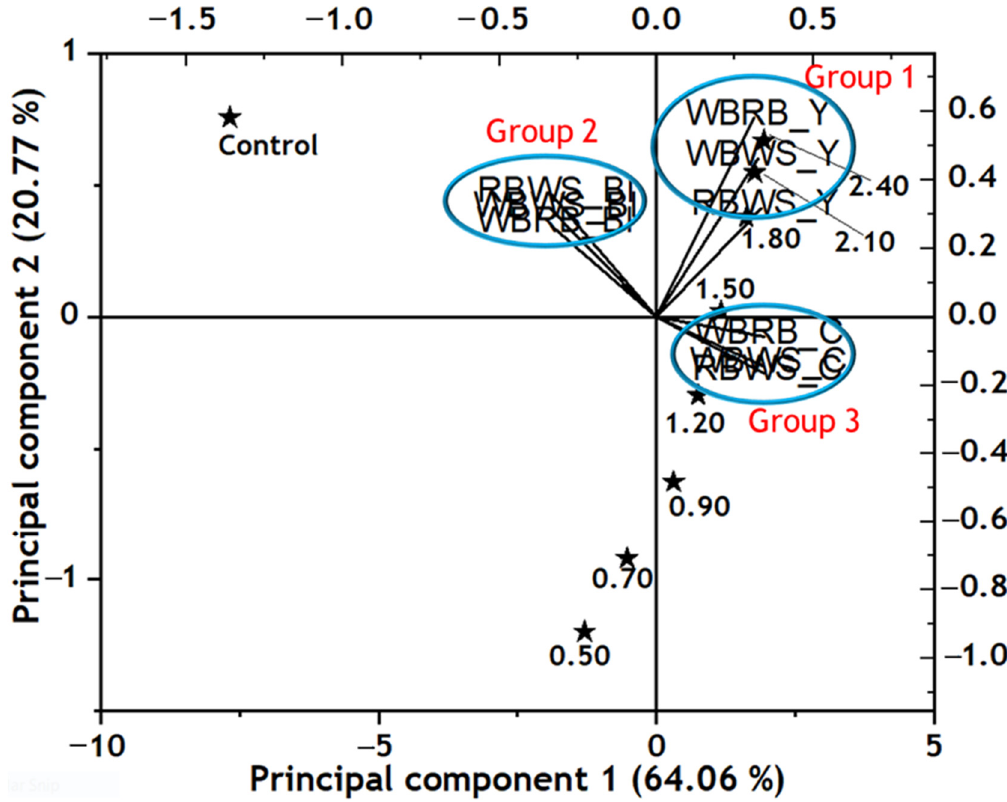
Figure 2. Bi-plot variables and scores of the first two principal components. WBRB = wheat bran + rice bran, WBWS = wheat bran + wheat straw, RBWS = rice bran + wheat straw, Y = yield, BI = browning index, and C = clarity. Control = pumpkin juice without enzyme extract, while ★ represents concentration of enzyme extracts (0.50 to 2.40) added to pumpkin juice. WBWS_C and RBWS_C in group 2 as well as WBRB_BI and WBRS_BI in group 3 were superimposed due to high similarity in their characteristics as shown by principal component analysis.